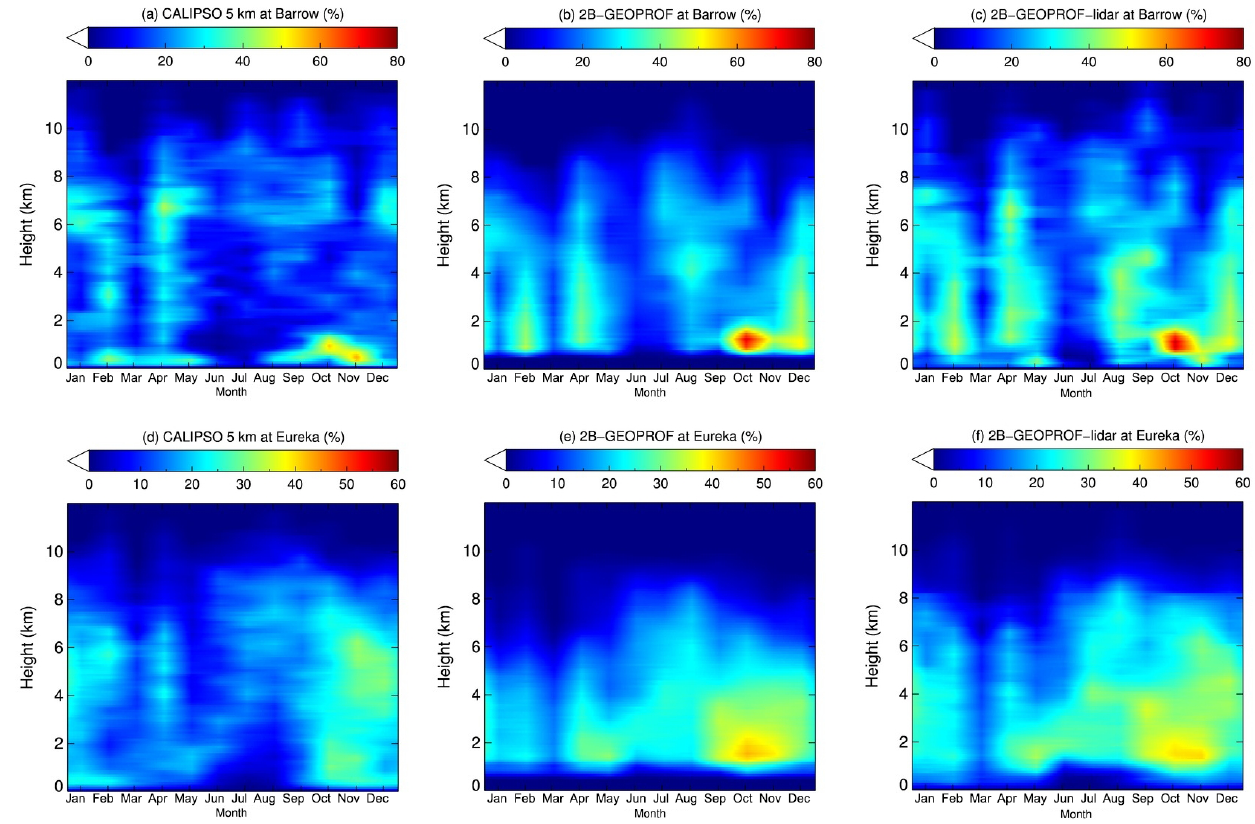
Figure 2. Cloud fraction vertical distribution 2006–2010 from (a) CALIPSO 5km, (b) 2B-GEOPROF, and (c) 2B-GEOPROF-lidar at Bar- row; (d) CALIPSO 5km, (e) 2B-GEOPROF, and (f) 2B-GEOPROF-lidar at